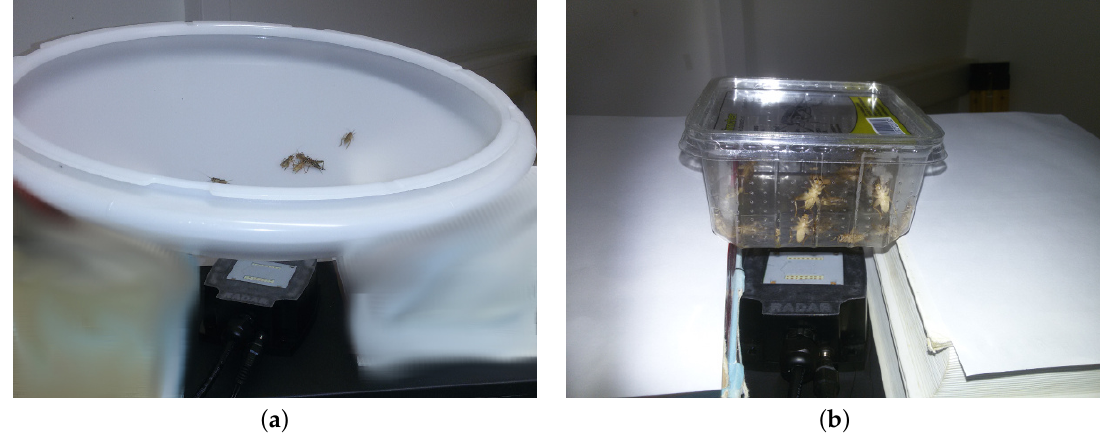
Figure 3. A few Acheta domesticus (house cricket) insects in: ( a ) a flipped light diffuser, ( b ) transparent packing